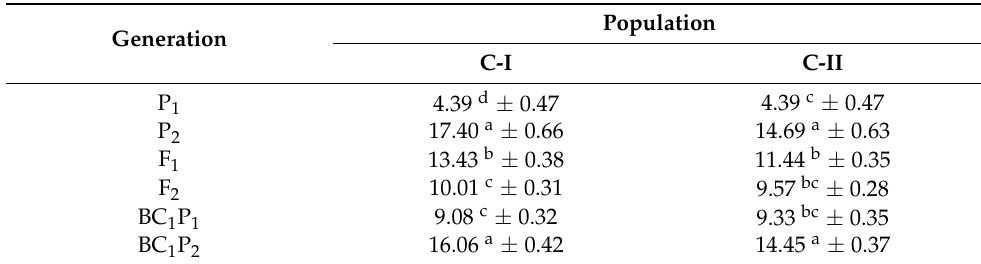
Table 4. Mean ( ± SE) comparison for lesion length (cm) among different generations of two popula- tions in Indian